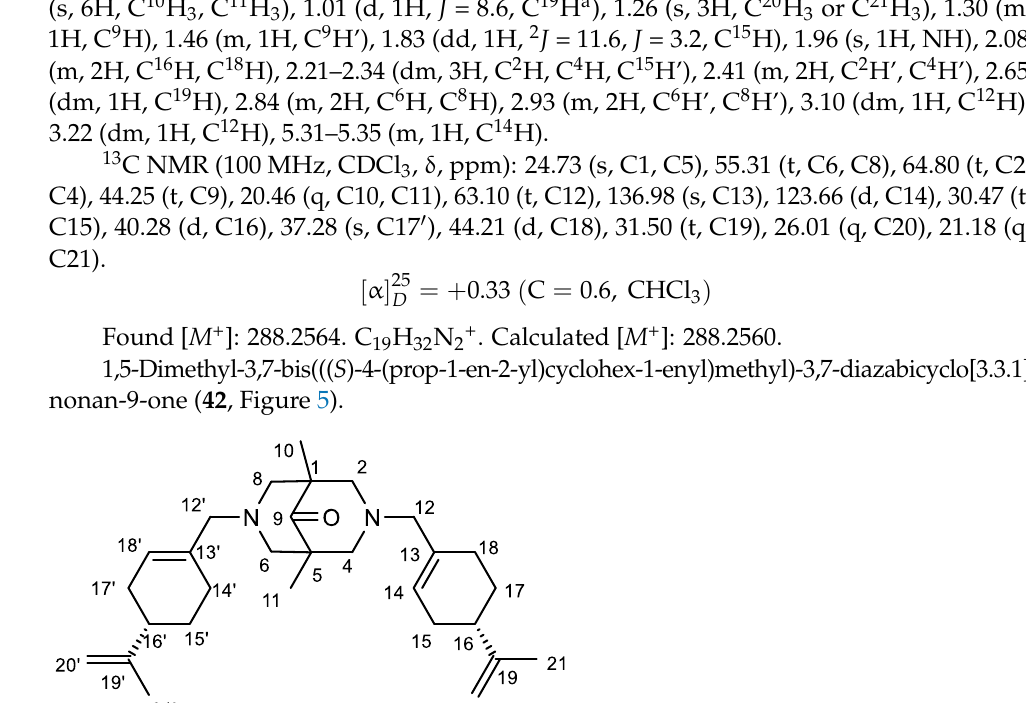
Figure 4. The structure of compound 38 . 214 mg (0.84 mmol) of amine 26 , 190 mg (0.88 mmol) of bromo-derivative 27 , 320 mg of K 2 CO 3 and 5 mL of CH 3 CN were added to the vial for the microwave reactor. The mixture was stirred until the organic substrates dissolved and placed in the MW reactor (temperature 75 °C, time 2 h). After completion of the reaction, the potassium carbonate was filtered off, the reaction mixture was evaporated, and 320 mg of the mixture was obtained. According to gas chromatography – mass spectrometry (GC/MS), a mixture of mono- and di- alkylation products of the amine was formed, including a Boc-lacking product. Dissolution of the resulting mixture in EtOAc resulted in a white precipitate (53 mg). The residual mixture was separated on silica gel in a chloroform:ethanol system, but no other components of the mixture could be isolated individually. 1